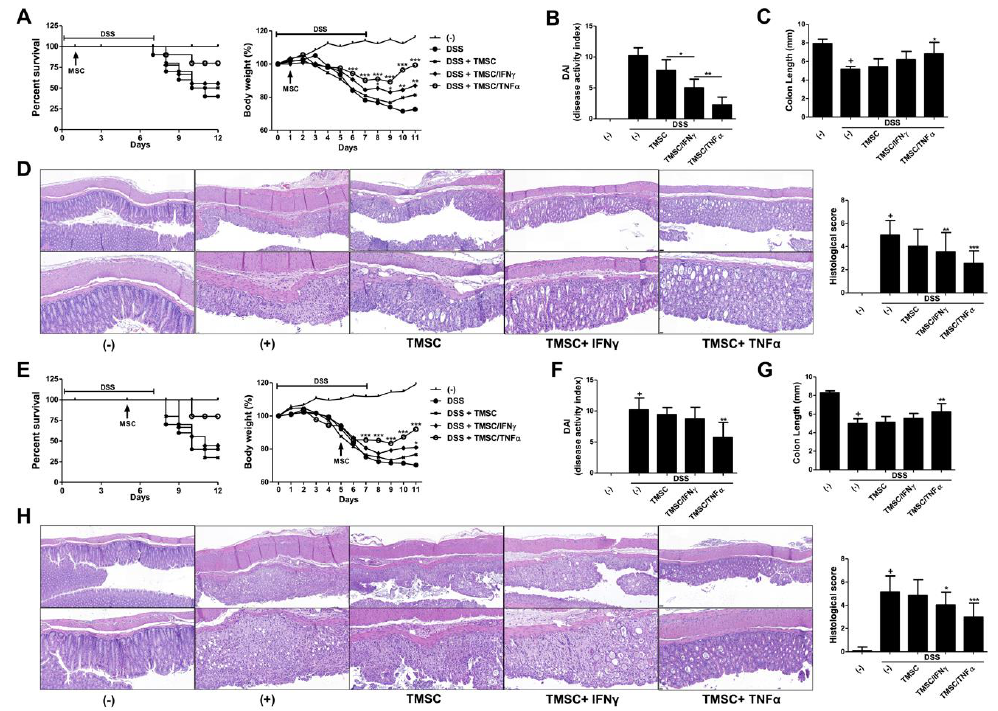
Figure 4. In vivo anti-inflammatory effects of TNF-α-primed TMSCs against colitis. DSS was used to induce acute colitis in C57BL/6 mice. TMSCs with or without pre-treatment were injected into colitic mice on either day 1 or day 5 of DSS induction to assess ( A–D ) preventive or ( E–I ) therapeutic potency ( n = 5 for non-induced healthy control marked as (-), n = 10 for each experimental group); ( A ) Survival rate and body weight loss were consistently monitored until day 12; ( B ) Disease activity index (DAI) was determined on day 10 post colitis induction; ( C ) Gross colon length was measured after sacrifice on day 12; ( D ) Colon tissues were processed and stained with H&E for histopathologic examination. The histological score was calculated by determining the entire epithelium destruction, the submucosal edema, and the inflammatory cell infiltration in the lamina propria and submucosa, scale bar = 50 µm ( top ), 20 µm ( bottom ); ( E–H ) The same methodologies were conducted for therapeutic potency assessment; All results are shown as mean ± S.D. p -value = * < 0.05, ** < 0.01, *** < 0.001, compared to the control group marked as ‘+’. 4. Discussion Given that the anti-inflammatory actions of MSCs are exerted in response to the host microenvironment, pre-treatment with proinflammatory cytokines can be the best way to enhance the immunomodulatory function of MSCs by practicing MSCs in the mimicked in vivo inflammatory milieu in advance [33]. To date, a number of studies have reported improvements in the immune- related function of MSCs following pre-treatment with certain cytokines. IFN-γ priming was demonstrated to enhance the immunosuppressive effects of human bone marrow-derived MSCs (BM-MSCs) mainly through the upregulation of IDO [34]. While one study showed that IFN-γ- primed adipose tissue-derived MSCs (AT-MSCs) exhibited further alleviation against experimental obliterative bronchiolitis [35], another literature suggested that BM-MSCs primed by IFN-γ alone was insufficient to produce immunosuppressive effects [10]. It has been also reported that pre-treatment with TNF-α could promote the anti-inflammatory effect of MSCs via increased secretion of IL-6 and IL-8, but on the contrary, one study claimed that TNF-α-driven enhancement represented a much weaker degree than IFN-γ [36]. These contradictory results led researchers to try other pretreatment regimens like a combination of multiple cytokines [37]. In the present study, we verified that TNF-α